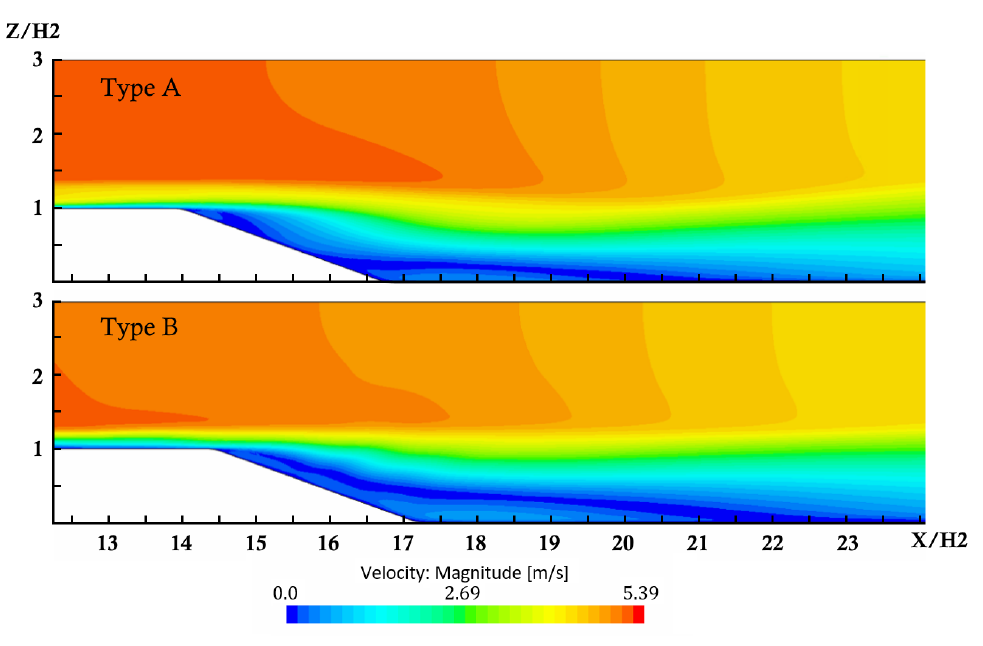
Figure 21. Simulated velocity field at the backward-facing ramp for type A and type B knitted wire meshes.